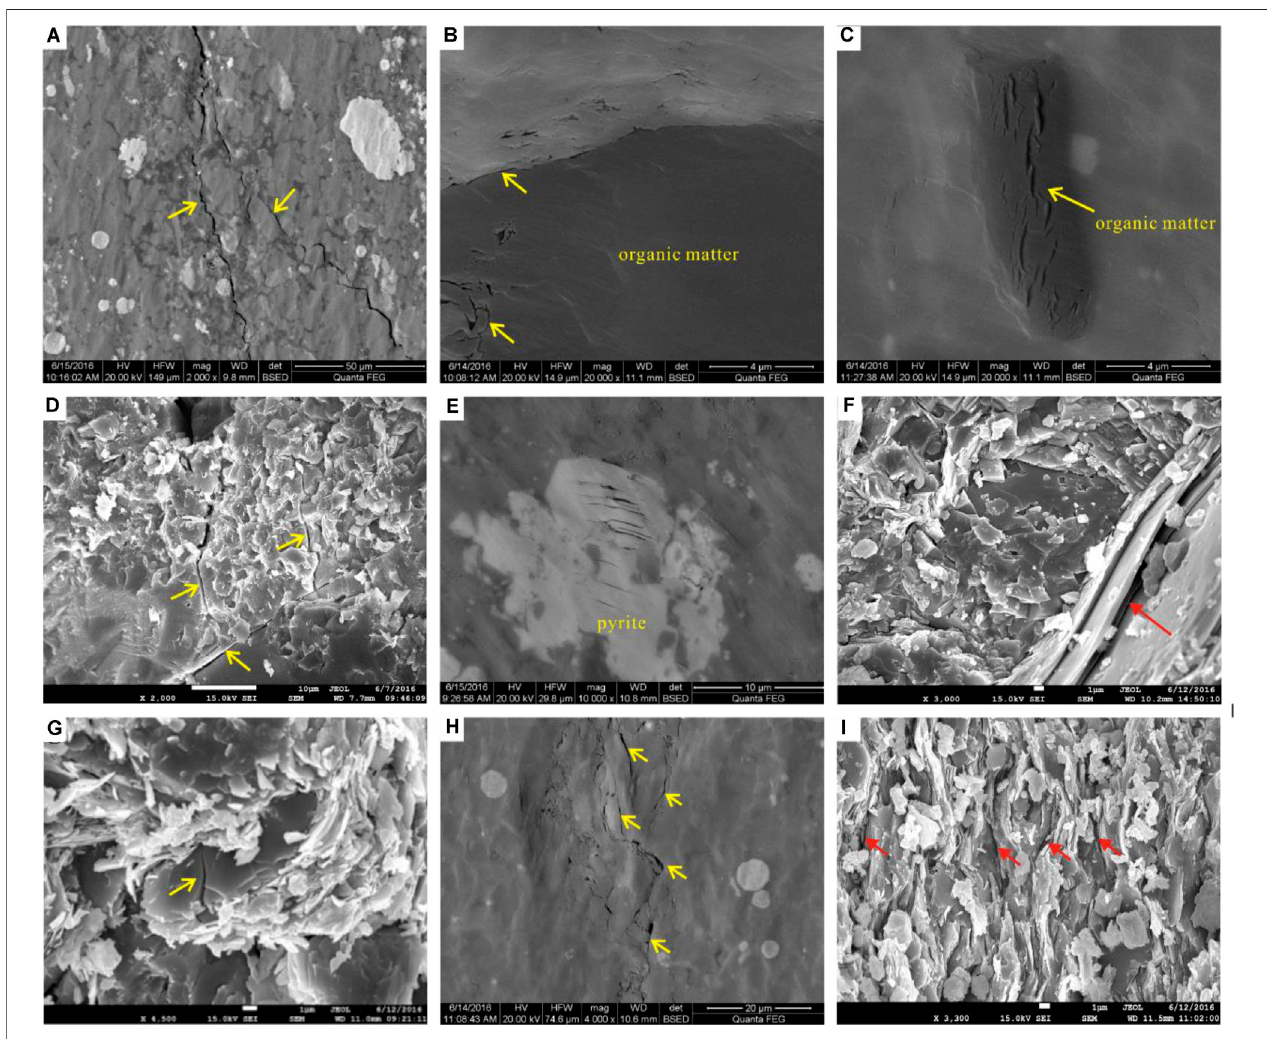
FIGURE 9 | Characteristics of the micro-fractures of the Niutitang shale. (A) 2014.53 m, micro-structural fractures; (B) 1939.94 m, fractures around the organic matter edge and fractures within the organic matter; (C) 1971.14 m, intra-organic matter fracture; (D) 1927.22 m, the intergranular micro-fracture of calcites; (E) 1999.31 m, the intergranular micro-fracture of pyrites; (F) 1985.65 m, the cleavage micro-fractures of mica; (G) 1939.94 m, the grain breakage fracture of feldspar; (H) 1963.92 m, the intergranular fractures of mud particles; (I) 1966.73 m, the directional arrangement of the fl ake clay minerals such as illite formed intergranular